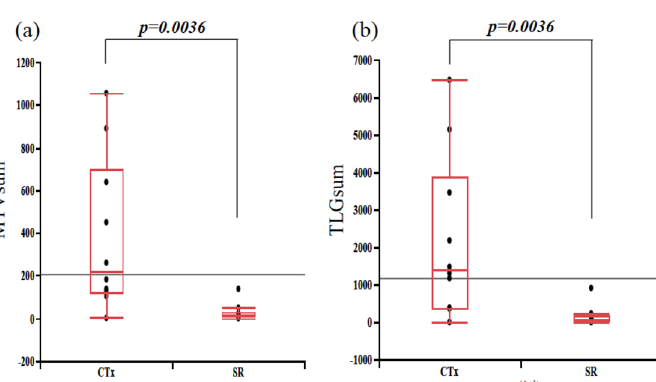
Figure 2. Comparisons of ( a ) sIL-2R (U/ml), ( b ) LDH (U/l), and ( c ) ΔALC (/µl) between SR and CTx groups.